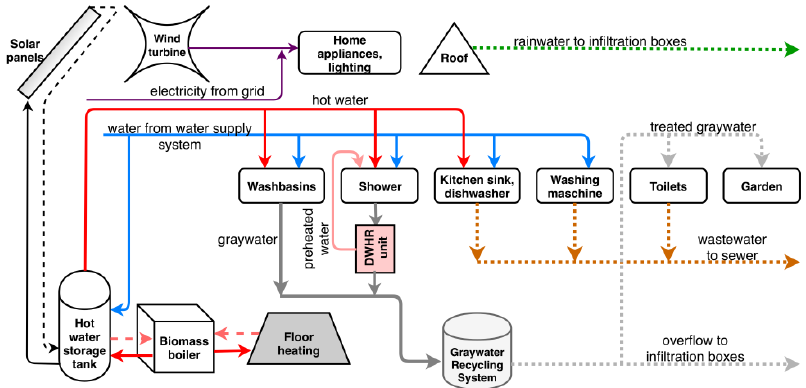
Figure 10. Diagram of system operation in Variant 7.